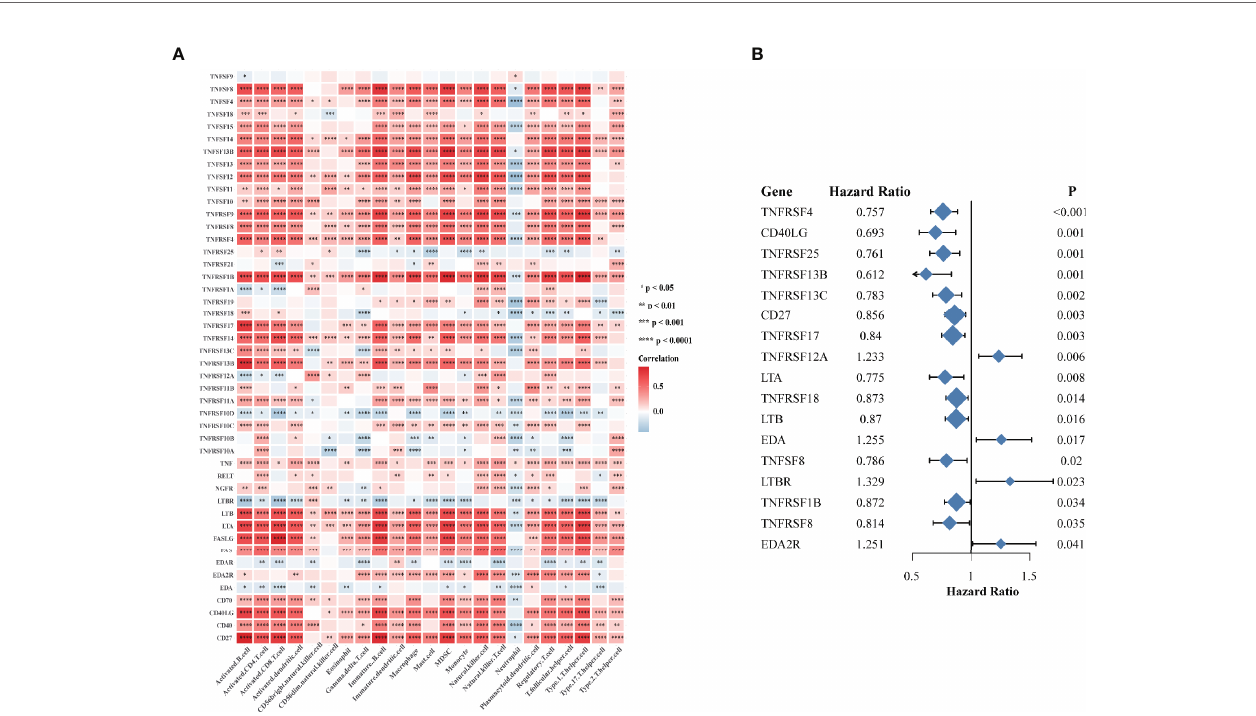
FIGURE 2 | The immune correlation and prognostic value of TNF family in HNSCC. (A) Correlation heatmap between 46 TNF family proteins and immune cells in the TCGA HNSCC cohort. Orange indicates positive correlation; blue indicates negative correlation. (B) The forest plot of the univariate Cox regression model depicting the 17 statistically signi fi cant prognostic factors in TNF family proteins in TCGA HNSCC cohort. Hazard ratio > 1: risk factors for survival. Hazard ratio < 1: protective factors for survival. (* p < 0.05, ** p < 0.01, *** p < 0.001, **** p <